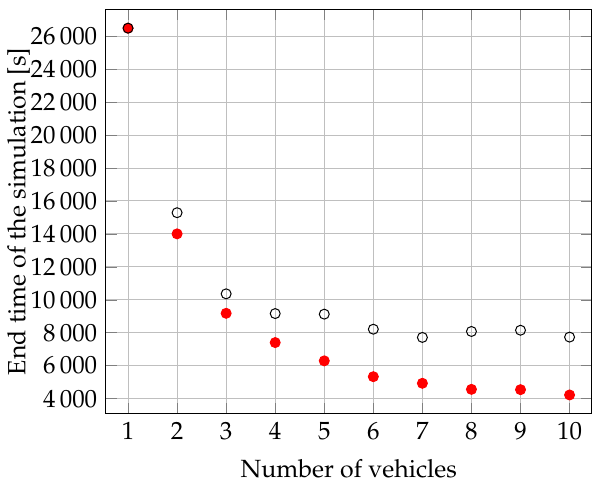
Figure 8. A comparison of the results for mixed